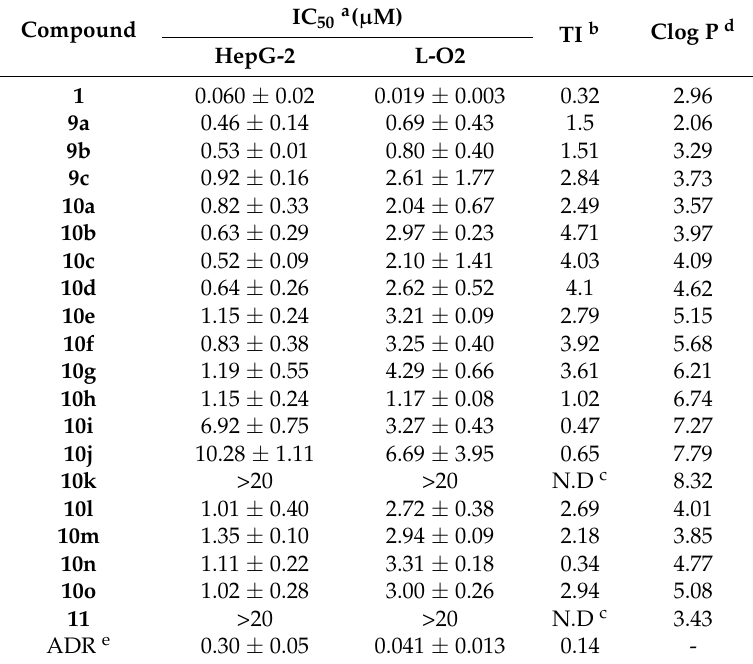
Table 2. The inhibitory activity and clog P of 9a – 9c , 10a – 10o , and 11 against the HepG-2 and L-O2 cell